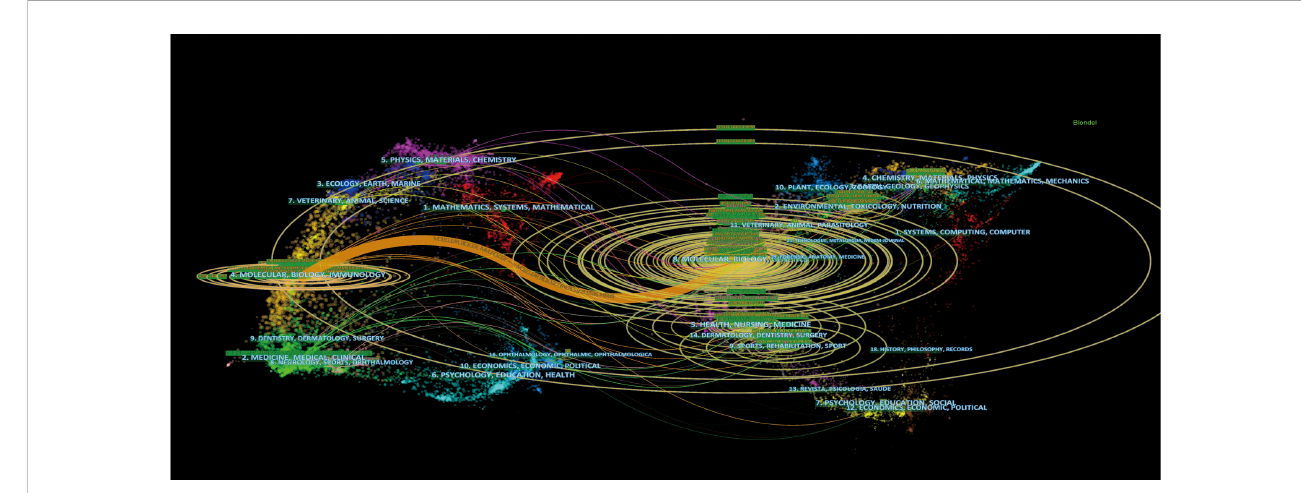
FIGURE 3 The dual-map overlay of journals related to MMP-OS research Notes: The citing journals were at left, the cited journals were on the right, and the colored path represents citation relationship.